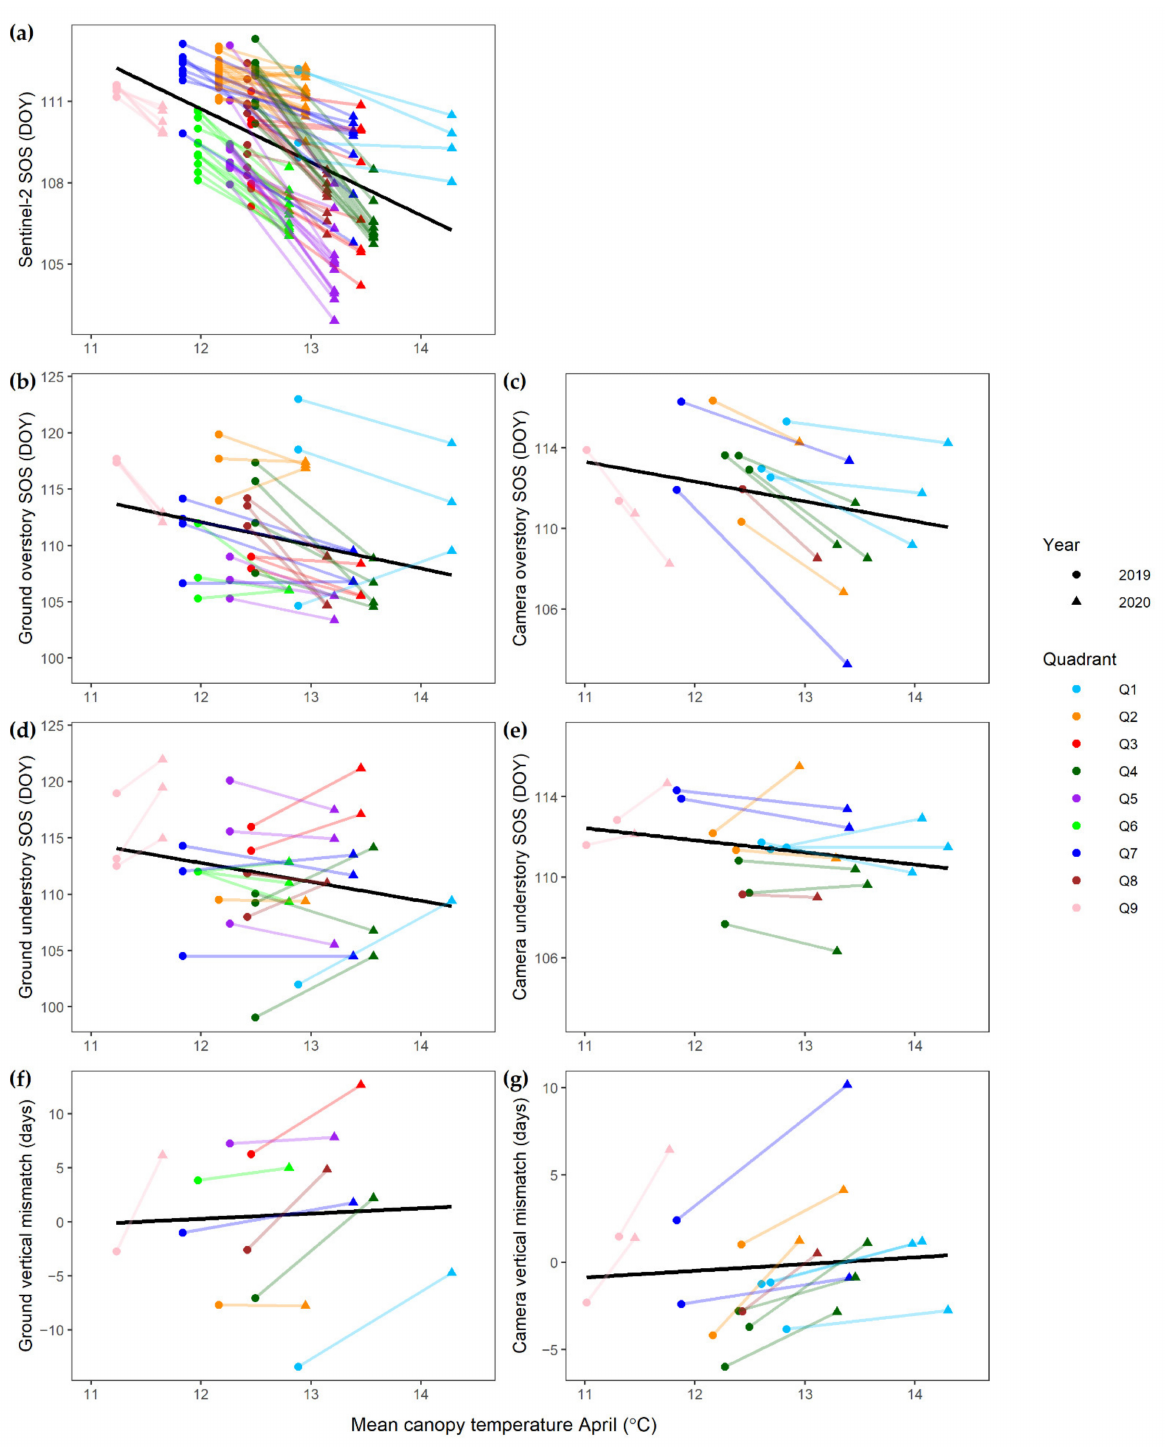
Figure 4. Effects of mean canopy temperature in April ( ◦ C) on Sentinel-2 SOS ( a ), overstory SOS by visual ground observations ( b ), overstory SOS by camera observations ( c ), understory SOS by visual ground observations ( d ), understory SOS by camera observations ( e ), vertical mismatch by visual ground observations, ( f ) and vertical mismatch by camera observations ( g ). Colors represent quadrants. Circles represent records from 2019, while triangles represent records from 2020. Colored lines connect the same individuals ( a , b , d ), ROIs ( c , e ), quadrant averaged values ( f ) or sites ( g ) between the two years. Thick black lines are linear regression